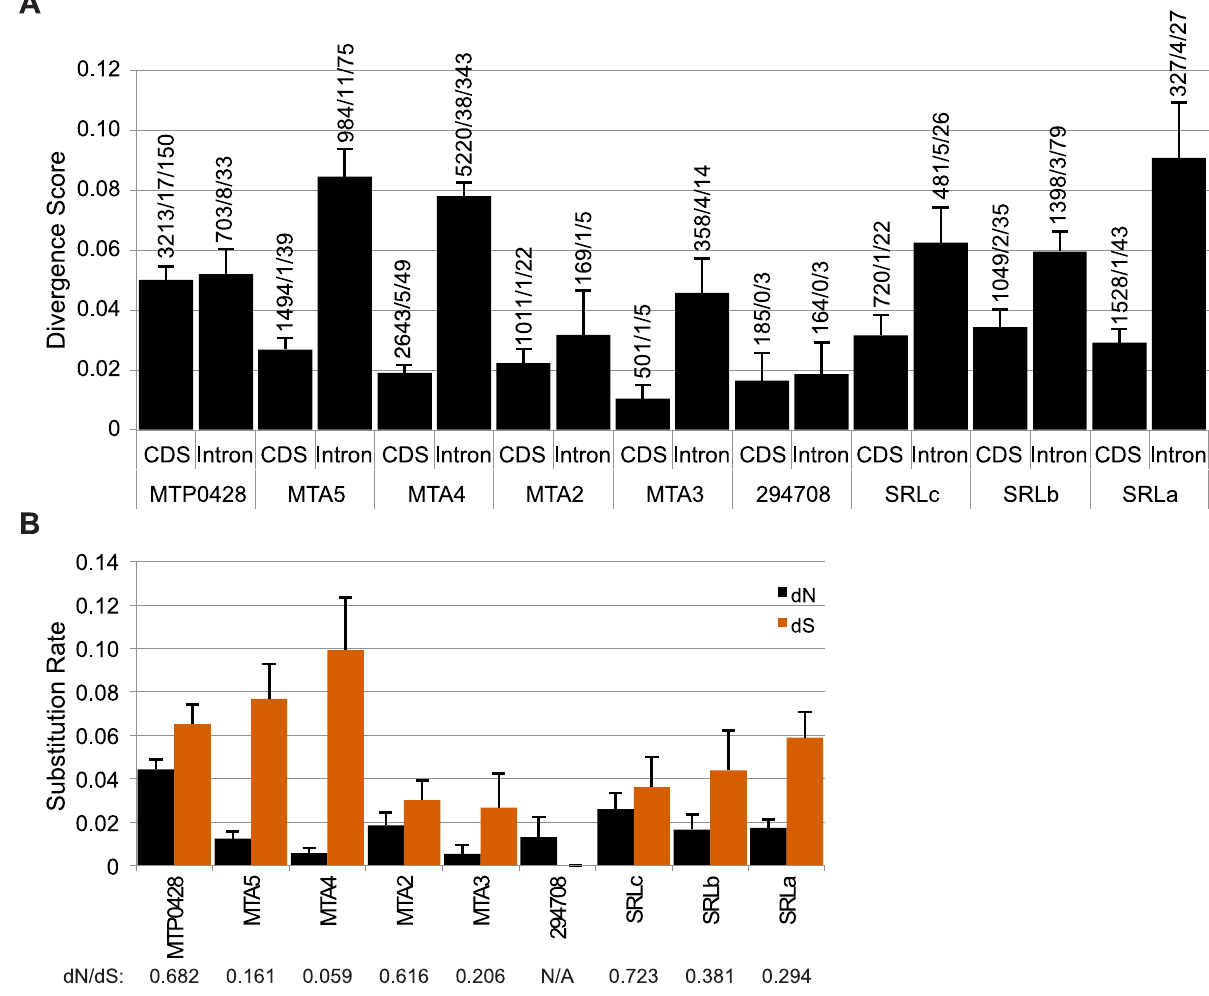
Figure 3. Divergence of autosomal and MT + duplicated genes. A. Bar graph of nucleotide divergence values [77] for alignments of coding (CDS) and intron sequences of MT + genes and their autosomal progenitors as shown in Figure 2. Bars depict divergence with standard error indicated by lines. Values above each bar show total number of aligned bases/number of indels/number of substitutions for the alignment. B. Synonymous (dS) and non-synonymous (dN) substitution rates for CDS alignments described in Panel A with the standard error indicated by the line on top of each bar. dN/dS ratios are shown below each gene.